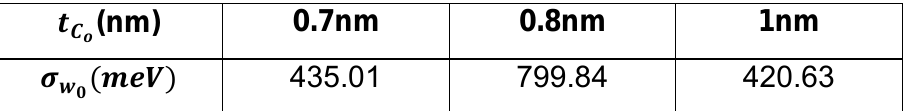
Table 4. Values of the Width of the distribution of energy barriers in each